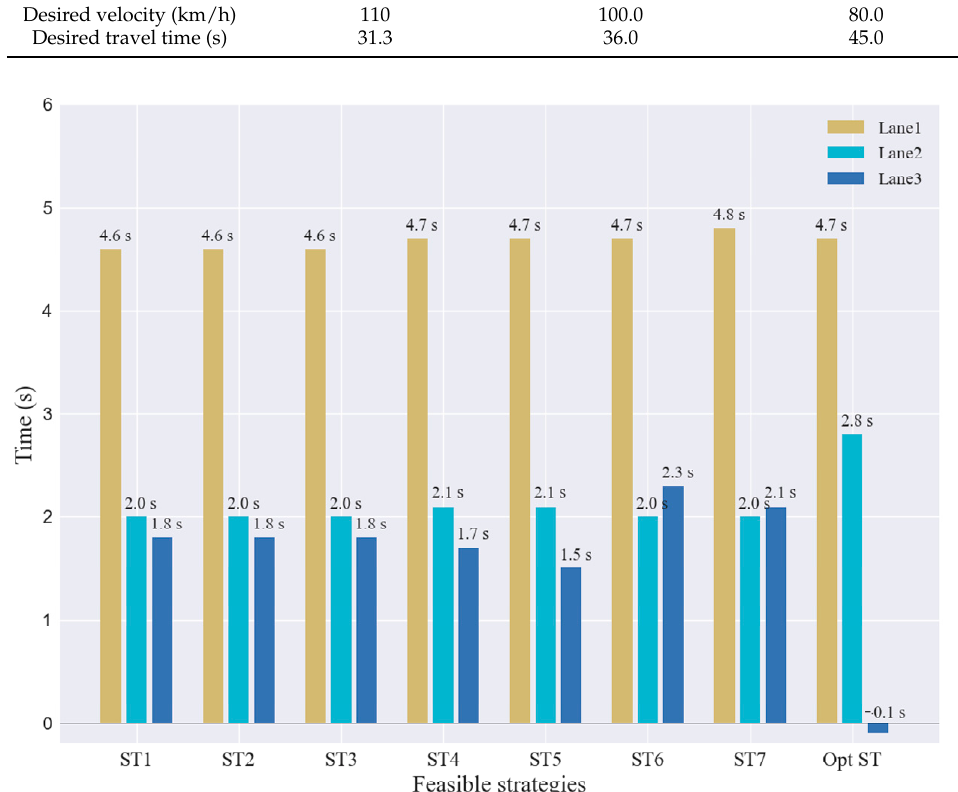
Figure 14. Impact on traffic flow operation of feasible strategies.